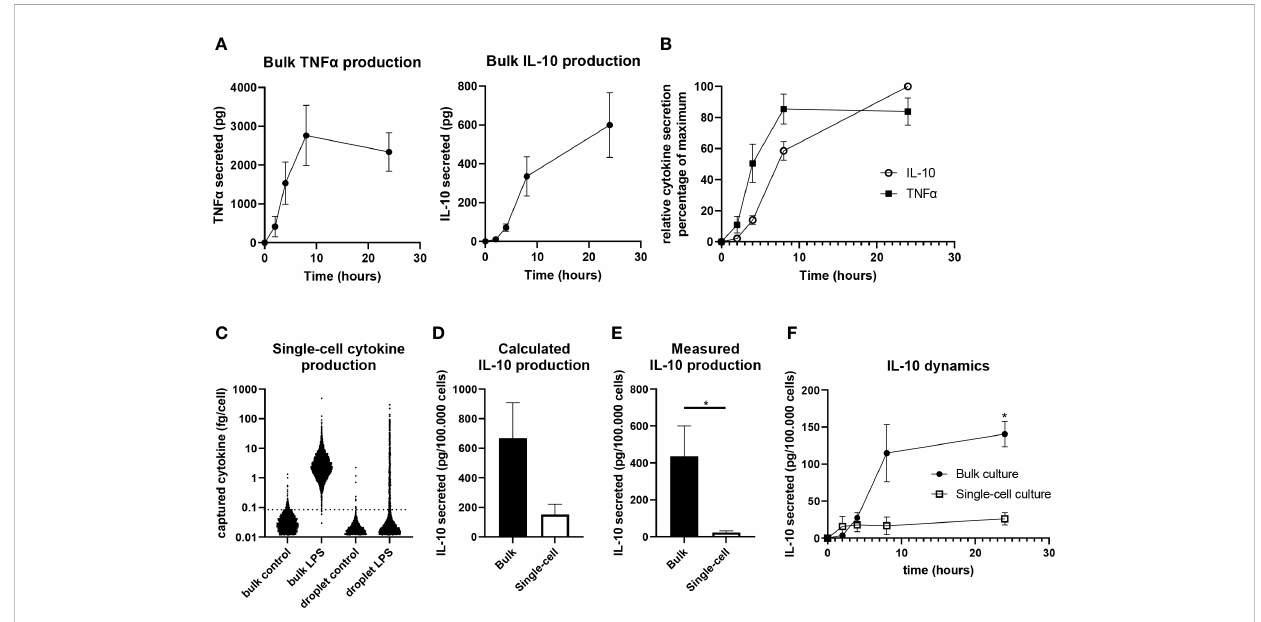
FIGURE 3 Quanti fi cation of IL-10 production in single-cell and bulk cultures. (A) Quanti fi cation of TNF a (n=5 independent donors) and IL-10 (n=9 independent donors) in bulk after LPS stimulation. (B) Relative secretion of TNF a (n=5 independent donors) and IL-10 (n=9 independent donors) as normalized to maximum per donor. (C) Quanti fi ed IL-10 production as calculated for individual cells of one representative donor using the titration curve of IL-10. (D) Total IL-10 production after 24 hours in bulk and single-cell culture as calculated using the IL-10 titration curve (n=3 independent donors). (E) Quanti fi cation of IL-10 production by bulk and single-cell LPS activated cells as measured using ELISA after 24 hours (n=7 independent donors), signi fi cance was tested via a paired t test with * indicating p<0.05 F) IL-10 production over 24 hours in bulk and single-cell culture as measured using ELISA (n=3 independent donors). Signi fi cance was tested using two-way RM ANOVA, and a post-hoc S ̌ ı ́ da ́ k test with * indicating